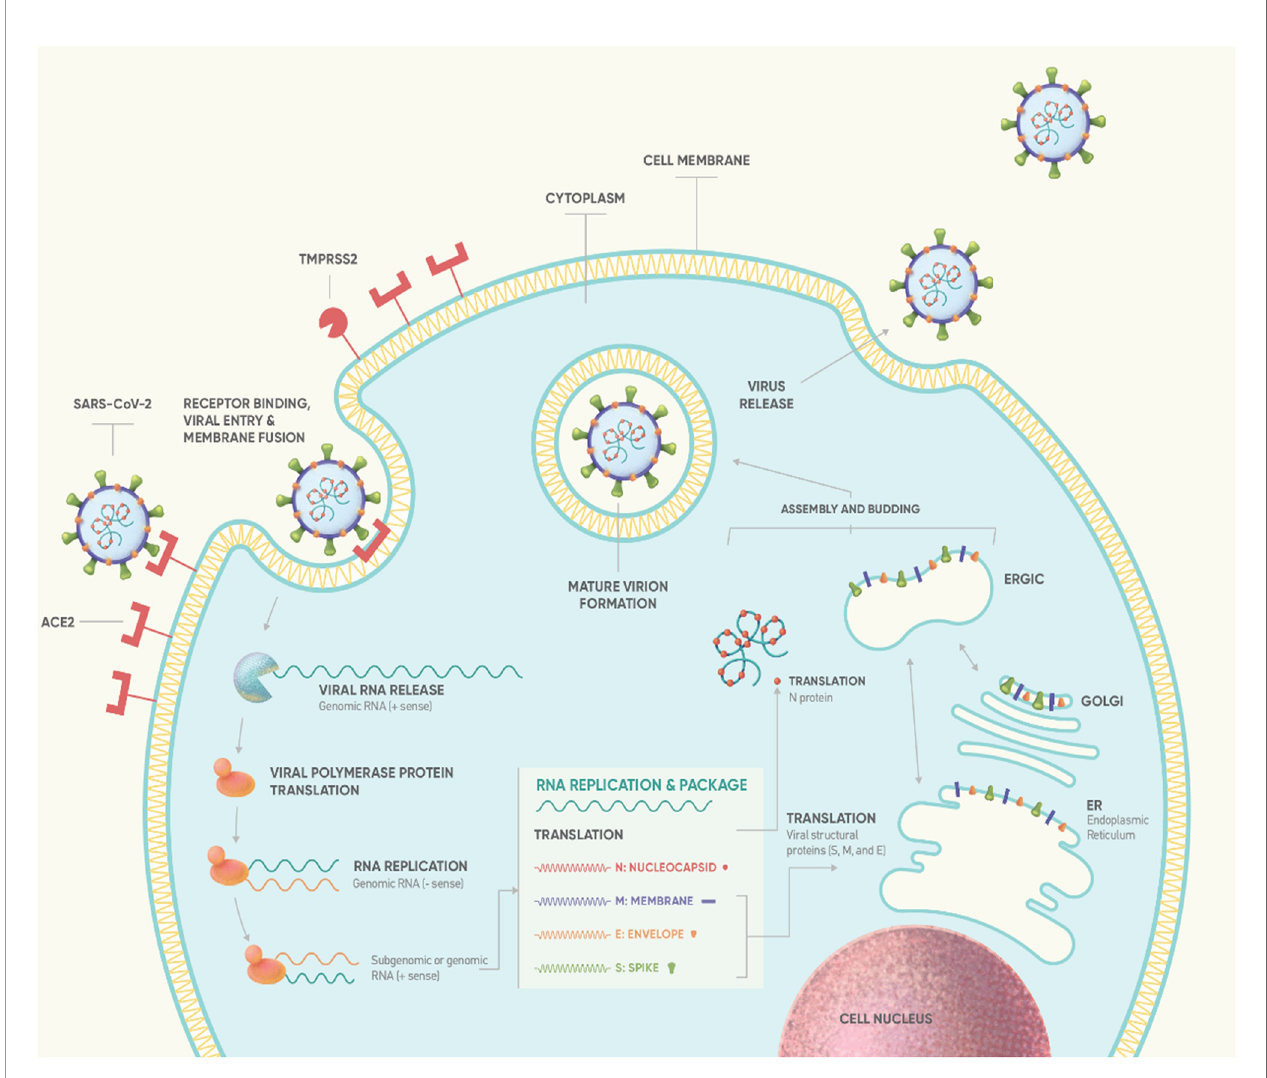
FIGURE 1 | Life cycle of SARS-CoV-2 (13). Binding of S protein to ACE2 receptor induces the proteolytic cleavage of S protein by cell surface-associated transmembrane protease serine 2 (TMPRSS2) and cathepsin. S1-RBD is recognized by ACE2 (14), mediating virus fusion and entry into the target cell via endocytosis (13, 15). Subsequently, the virus releases its positive-sense RNA-strand into the cytoplasm which serves as template to produce full length negative- sense RNAs by a reaction catalyzed by RTC. Using ribosomes of infected cell, virus ORF1a and ORF1ab are translated producing the pp1a and pp1ab polyproteins. Replication of viral RNA and N protein is then followed, mediating the packaging of viral RNA. Simultaneously, genes encoding S, M and E protein are transcribed and translated in the ER and transported to Golgi complex to form ER – Golgi intermediate compartment (ERGIC). Virus assembly and budding is mediated through the interaction between the RNA-N complex and the ERGIC creating a mature virion. Finally, the newly formed virion is released from host cell via exocytosis (13, 15, 16). According to estimated data of viral dynamics during in vitro experiments, SARS-CoV-2 requires approximately 10min to enter susceptible cell lines and about 10hrs to replicate intracellularly (the so-called eclipse period) such that 10 3 progeny virions are released from a single cell ( ‘ burst ’ size: ~10 3 ) through continuous budding (17). ACE2, angiotensin-converting enzyme 2; ER, endoplasmic reticulum; RBD, receptor-binding domain; RTC, replicase-transcriptase